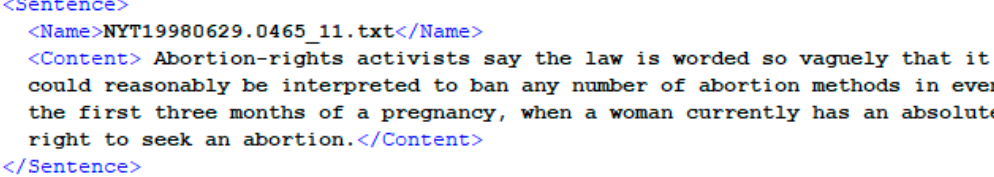
Figure 2. Example of the sentence part within the document from TREC 2003 novelty track.